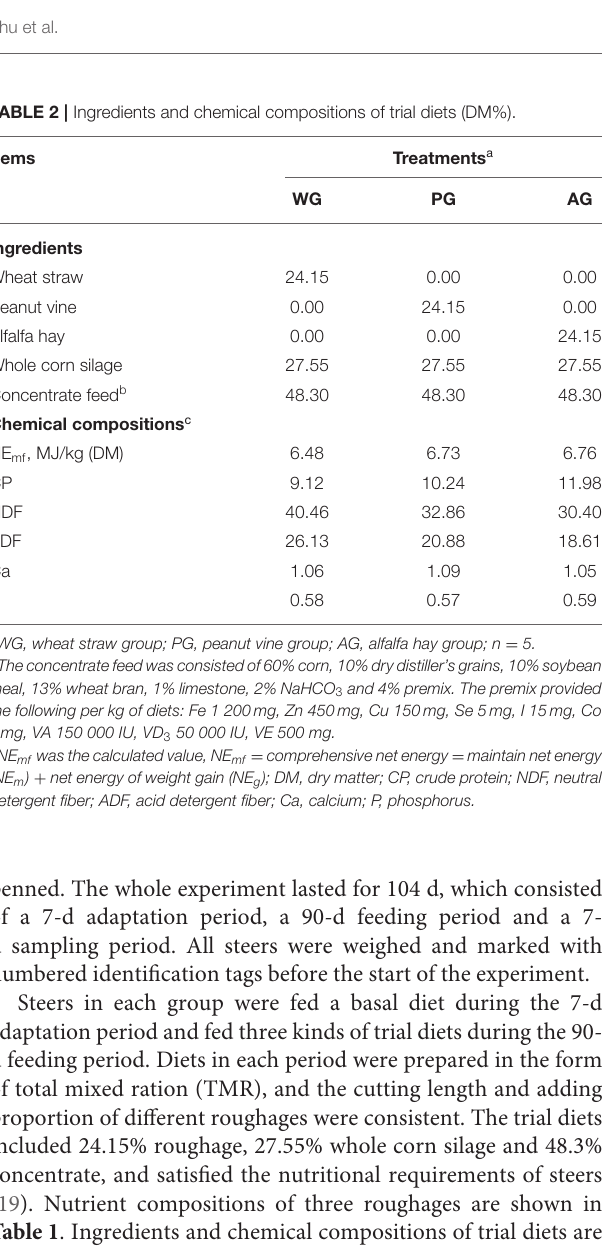
water, and allowing 5–10%